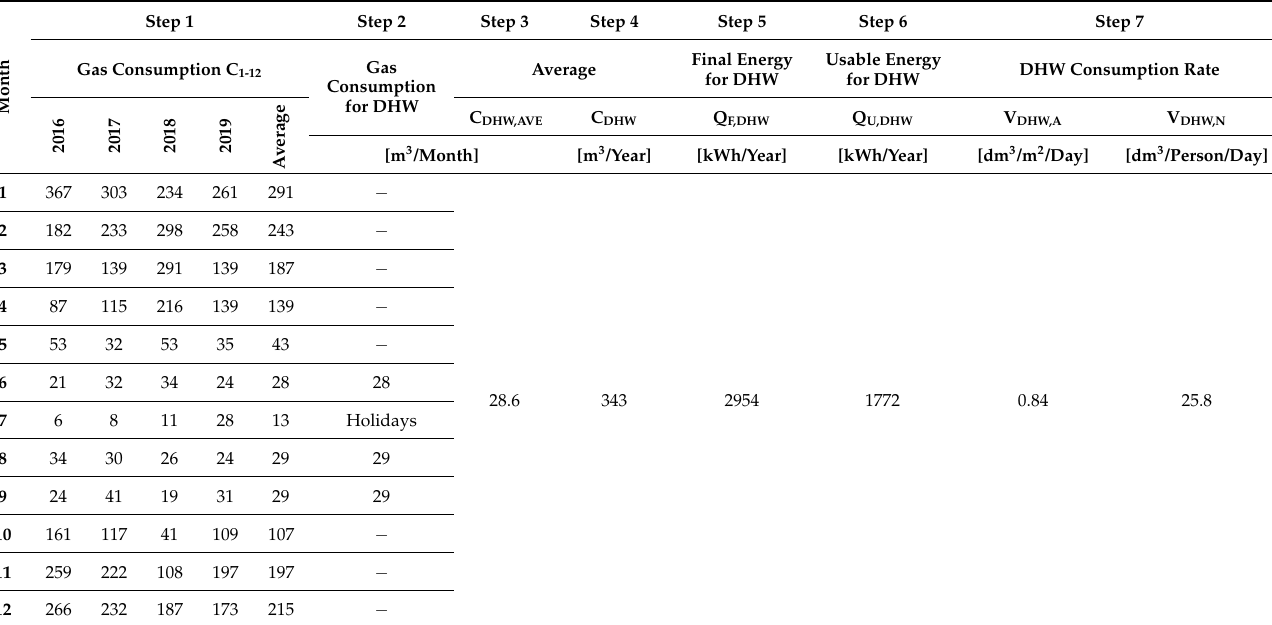
Table 3. Determination of DHW consumption indicators for building B1 (according to the diagram in Figure